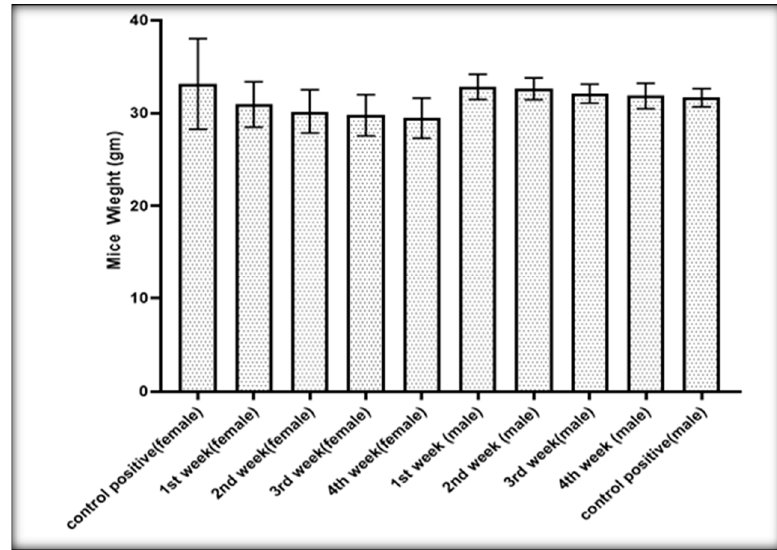
Figure 9. Effect of AgNPs on the weight of the infected mice with hydatid cysts.